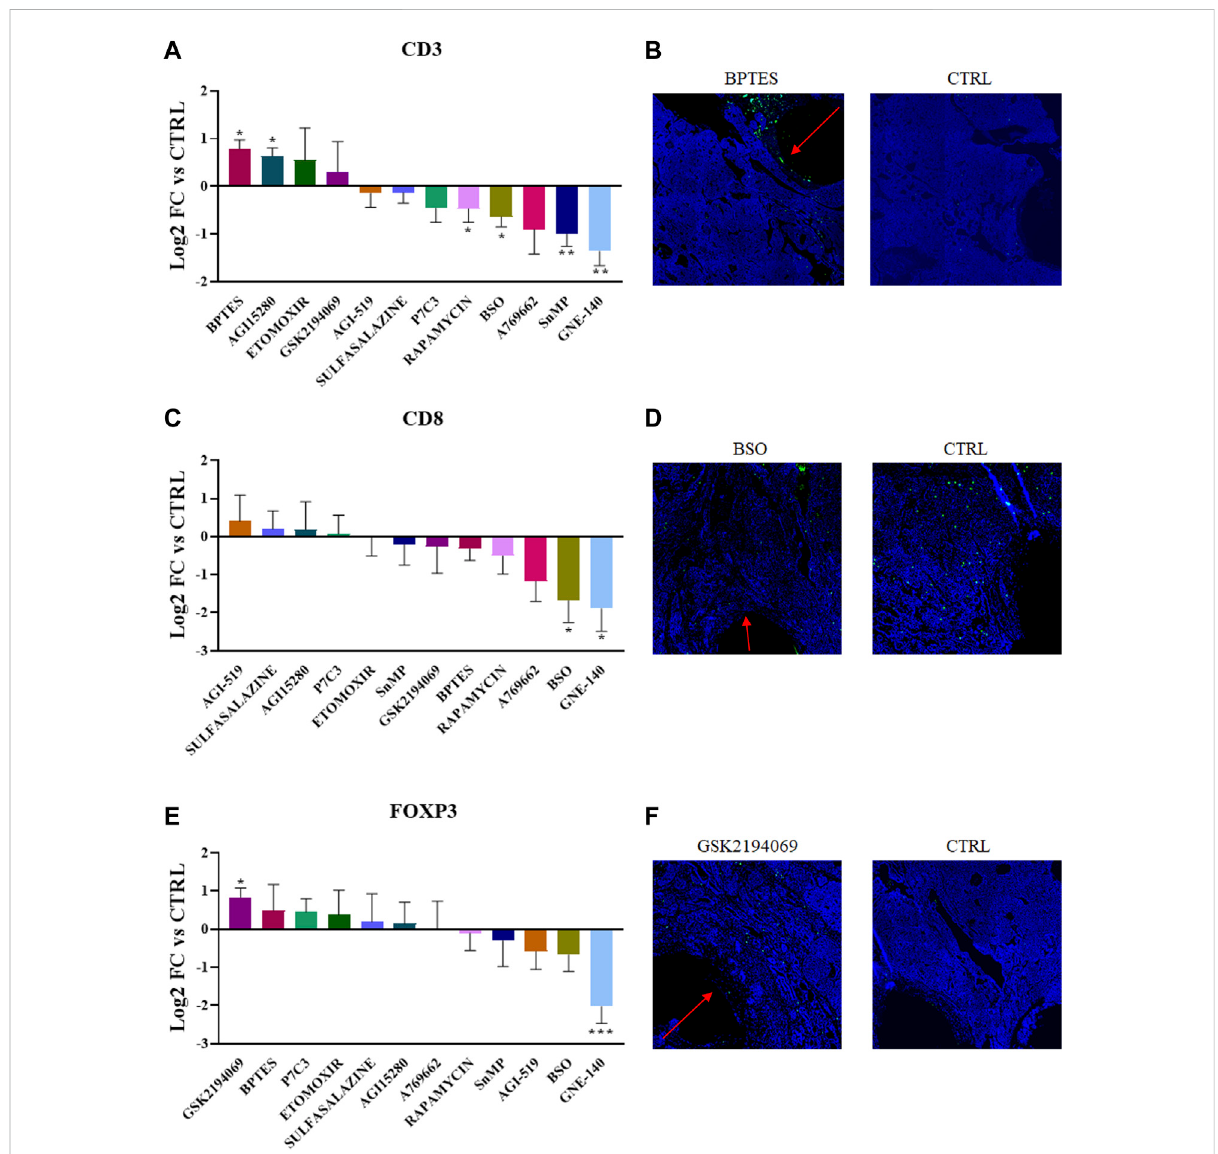
FIGURE 3 (A,C,E) Quanti fi cationofCD3 + ,CD8 + andFOXP3+abundanceinthecorrespondingregionofeachdrugperturbation.ValuesaretheLog fold change normalizing the number of positive cells detected in the ROI vs. positive cells in the control region of the same tumor. p -values indicate comparison between signal intensities at each drug site compared to Control (* p < 0.05, ** p < 0.001 *** p < 0.0001) (B,D,F) Representative images showing the IF/IHC staining on the tumor